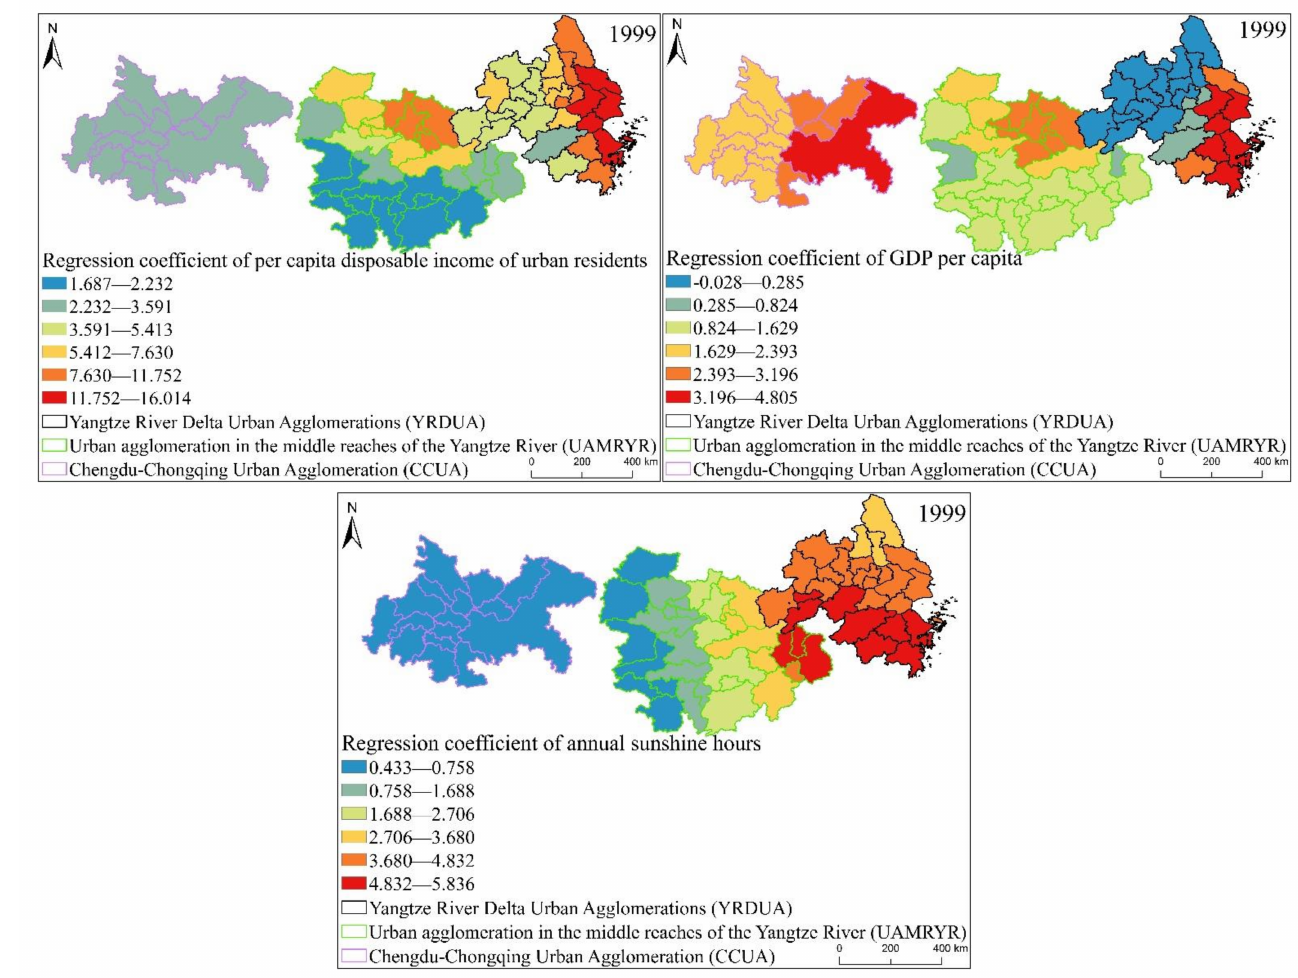
Figure 19. The spatial distribution map of the regression coefficients of the GWR model influencing factors of EPC in the three major urban agglomerations of the YREB in